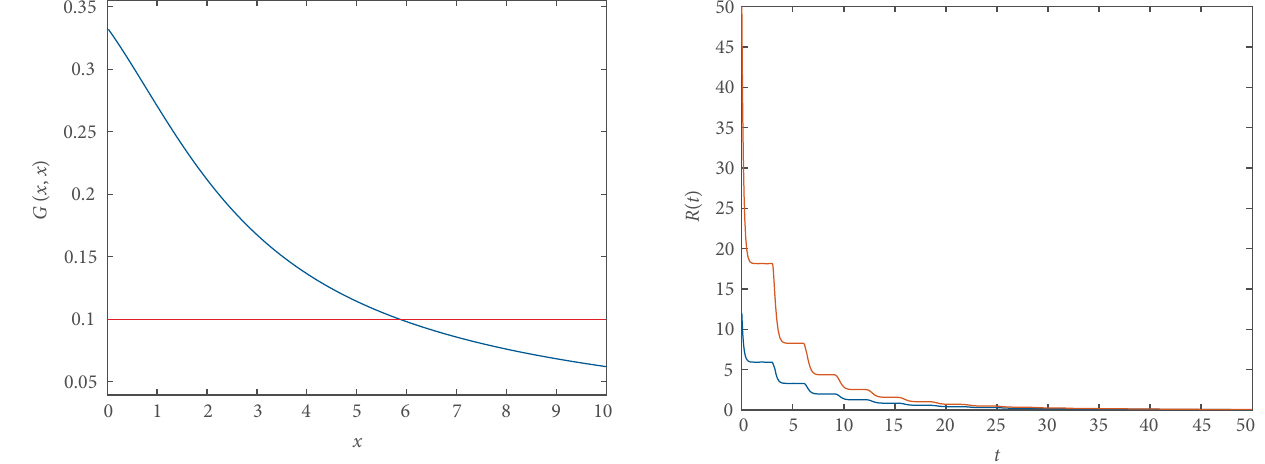
for ̄휎 = 10,휇 = 1, ̃휎 = 3,훽 = 2 푓(푥)